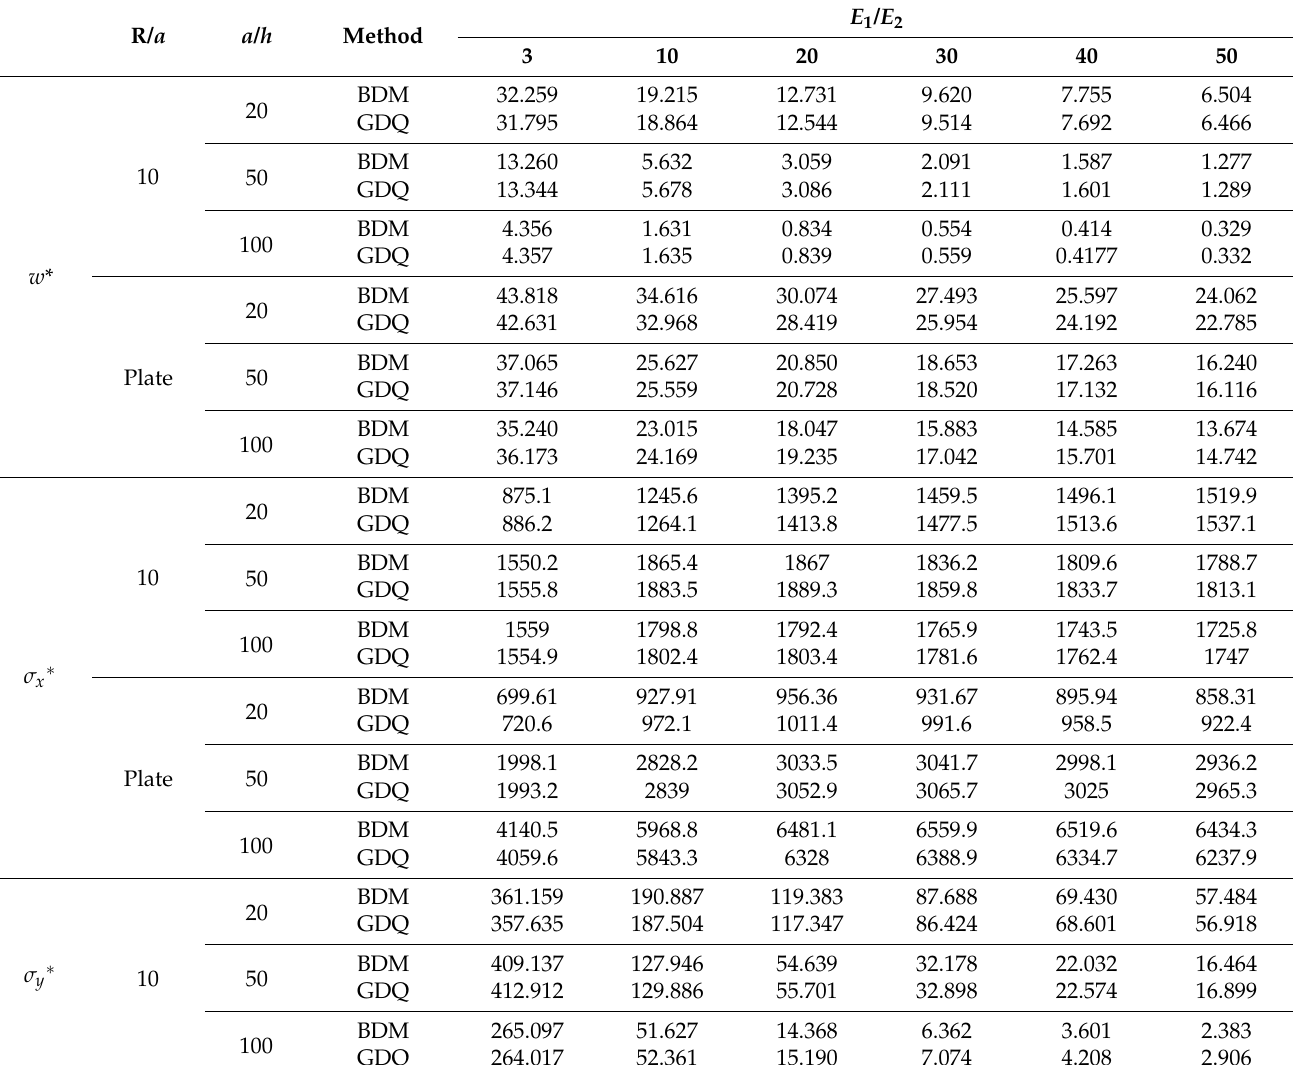
Table 5. Normalized central deflections of cross-ply [0 ◦ /90 ◦ /0 ◦ ] laminated shells under uniform